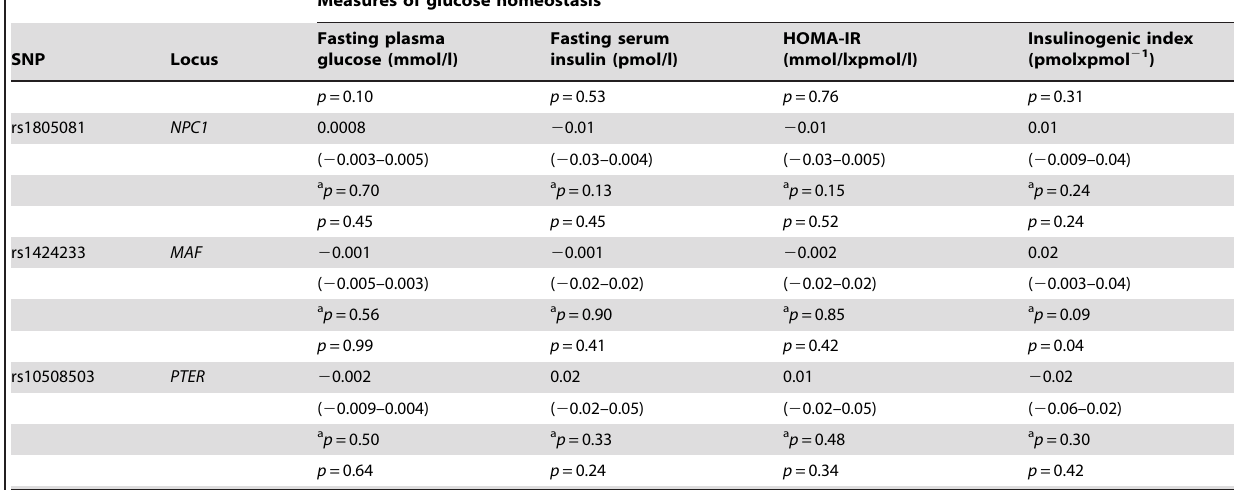
Data are presented as effect sizes (95% CI) per allele and p -values. a Effect sizes are adjusted for age, sex and BMI and are given as percentages since the traits are logarithmically transformed, and p -values are specified for the additive model and adjusted for age, sex and BMI. P -values without a are only adjusted for age and sex. Homeostasis model assessment of insulin resistance (HOMA-IR) was calculated as ((fasting plasma glucose (mmol/l) 6 fasting serum insulin (pmol/l))/22.5). Insulinogenic index was calculated as ((serum insulin 30 minuttes